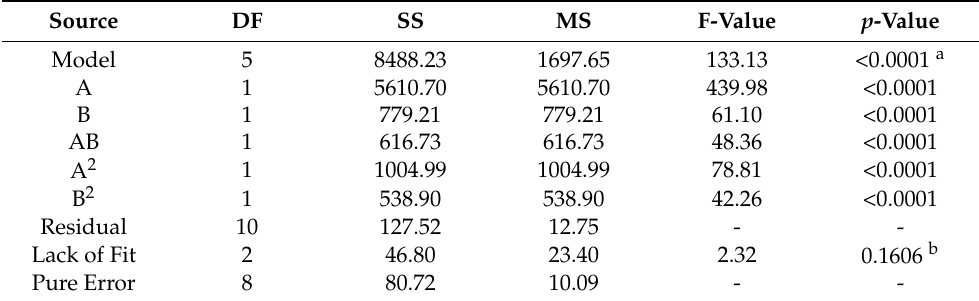
Table 2. ANOVA analysis for response surface second ‐ order model. The considered responses are the efficiency of P extraction.